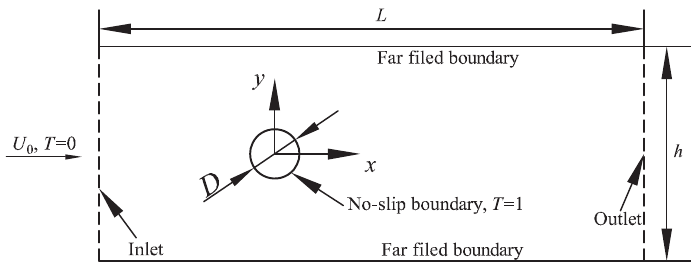
Figure 3. Schematic of heat transfer around a stationary cylinder in power-law fluid